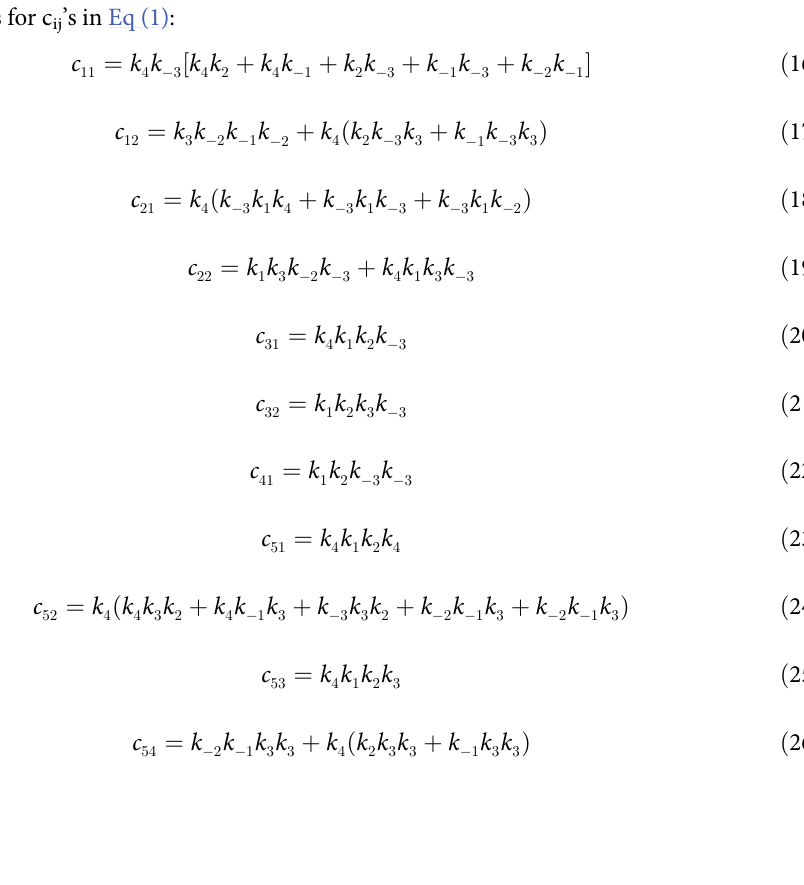
S1 Fig. Chemical mechanism of sirtuin-catalyzed deacylation and modes of sirtuin activa- tion. Following sequential binding of acylated peptide substrate and NAD + cofactor, the reac-